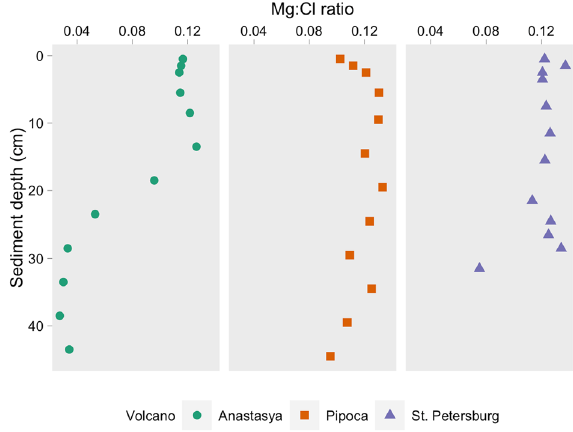
Figure 4. Pore water profiles of the Mg:Cl ratio in the three mud